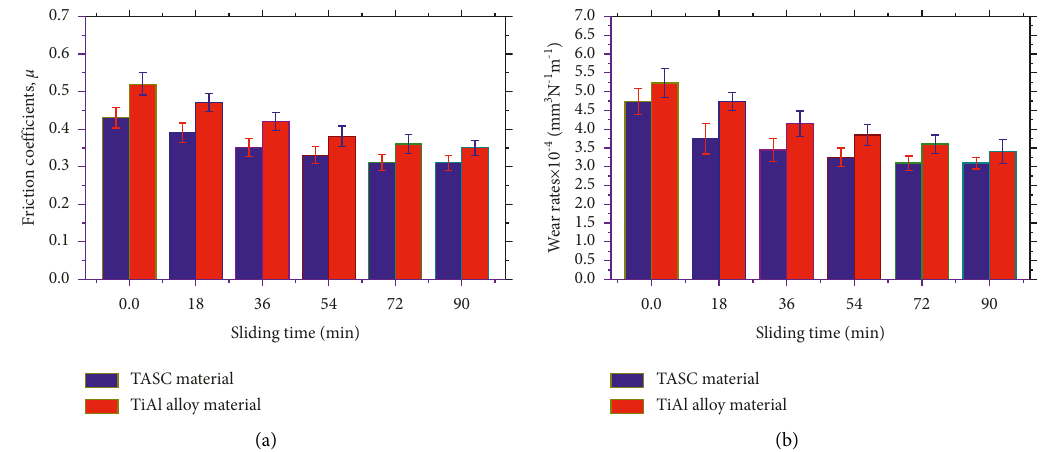
Figure 4: Typical friction coefficients (a) and wear rates (b) of the TASC with increases of sliding times from 0 min to 90 min.